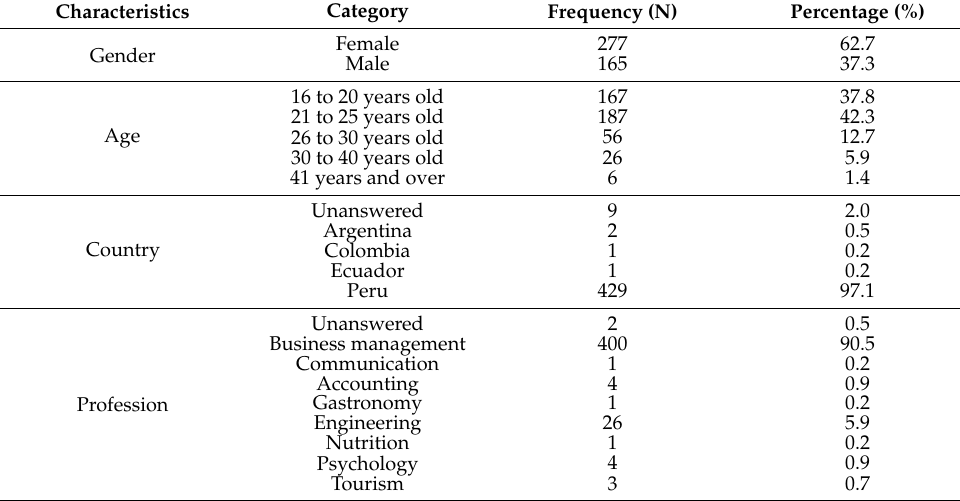
Table 1. Descriptive statistics of respondents (N =